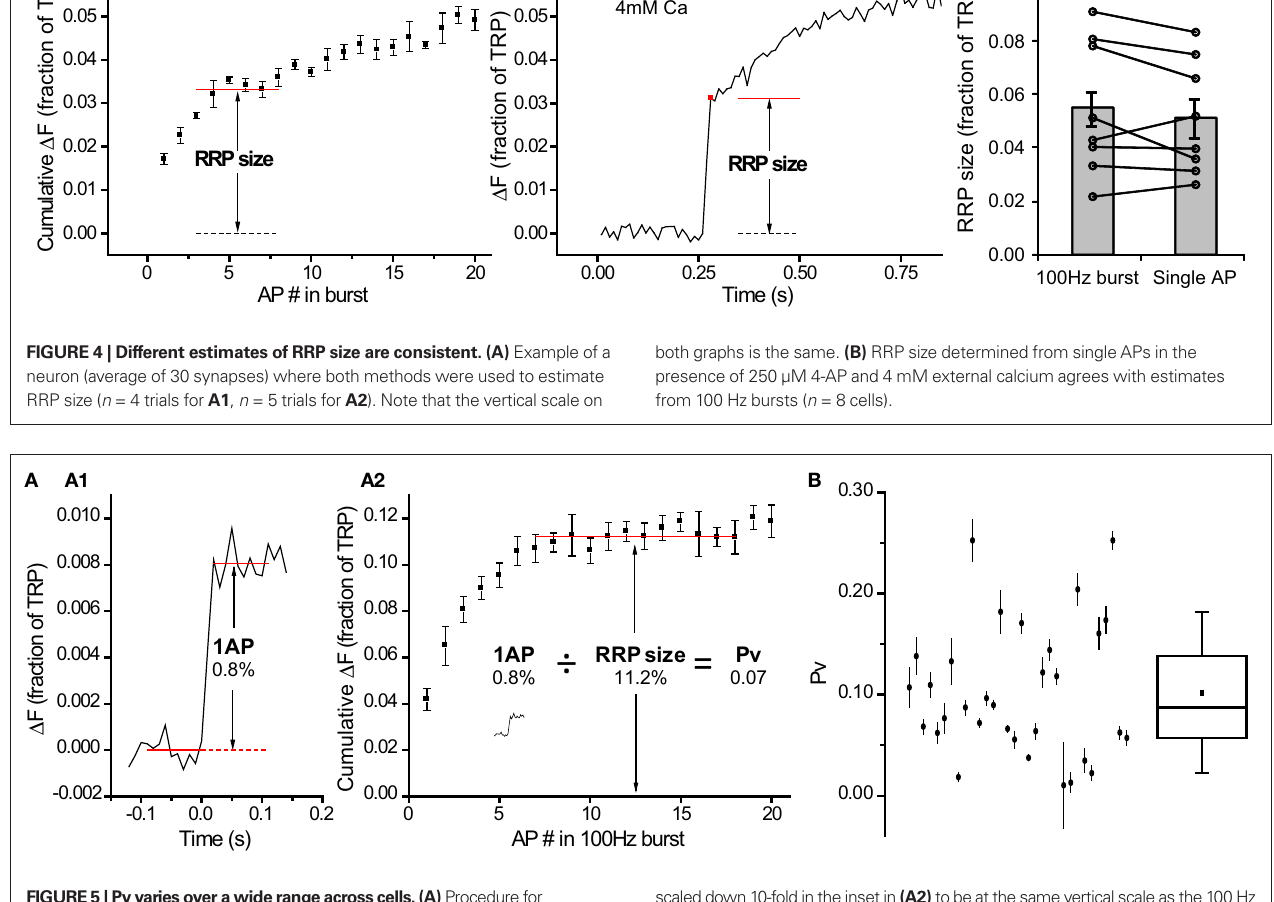
scaled down 10-fold in the inset in (A2) to be at the same vertical scale as the 100 Hz burst measurement. (B) Pv determined with this protocol in 32 cells (see Materials and Methods for explanation of error bars). Box whisker plot shows the median (line), mean (point), 25–75 percentile (box) and 10–90 percentile (whisker)